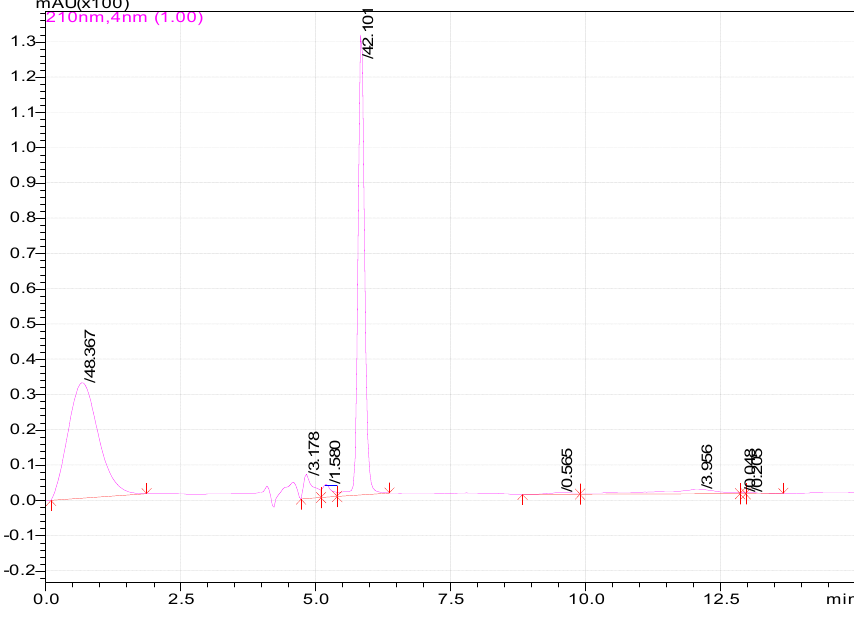
Figure 1. Liquid chromatography results.